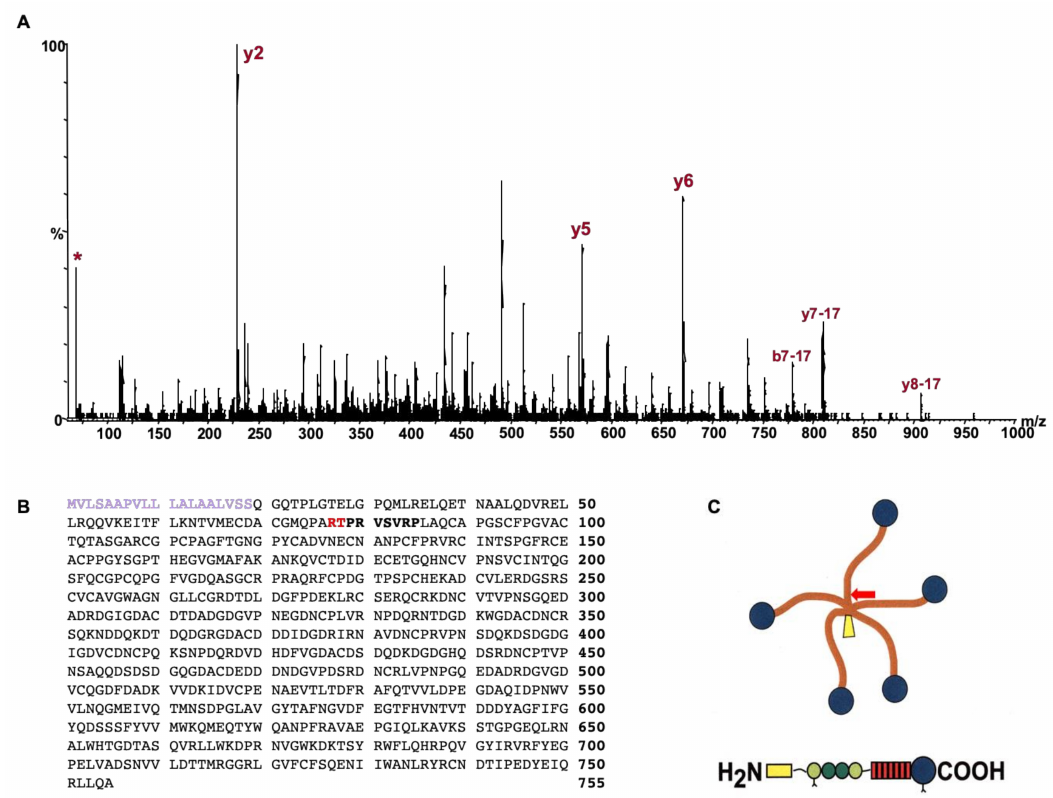
Figure 2. ( A ). Tandem mass spectrum of the neoepitope peptide “TPRVSVRPL” generated after chymotrypsin digestion and identified by mass spectrometry. The matching b- and y –ion fragments are labelled and the immonioum ion of proline is labeled with (*). ( B ) COMP sequence showing the cleavage site (in red) identified by mass spectrometry. The signal sequence is shown in purple. ( C ) Approximate location of the cleavage site after the 58th amino-acid and close to the disulphide bonds of the junctional region of COMP